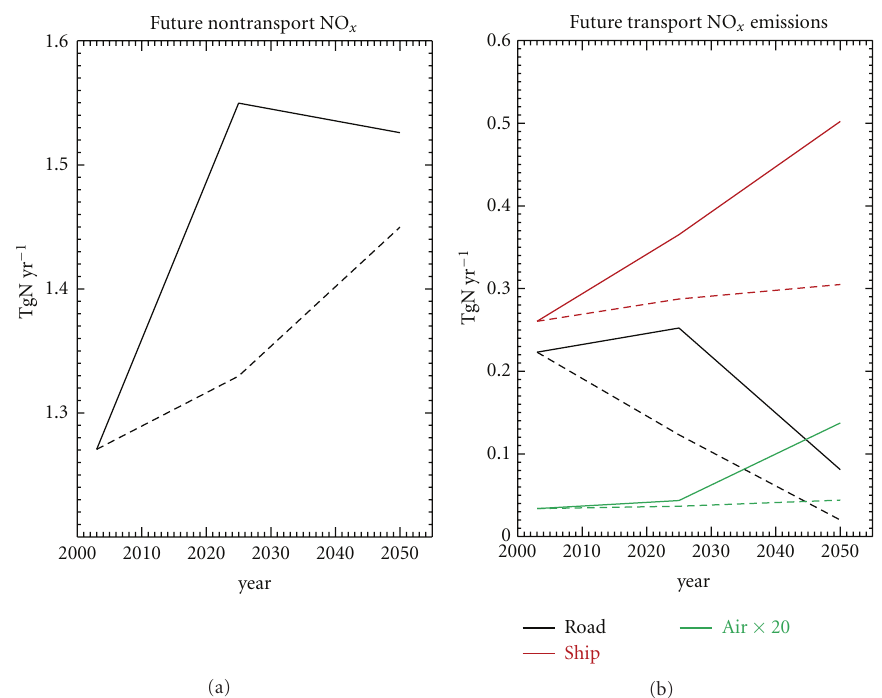
Figure 2: The evolution of (i) non-transport- and (ii) transport-based anthropogenic NO x emissions for West Africa (0–30 ◦ N, 20 ◦ W–10 ◦ E) for the timeline 2000–2050. Both the A1B (solid line) and B1 (dashed line) future emission scenarios are